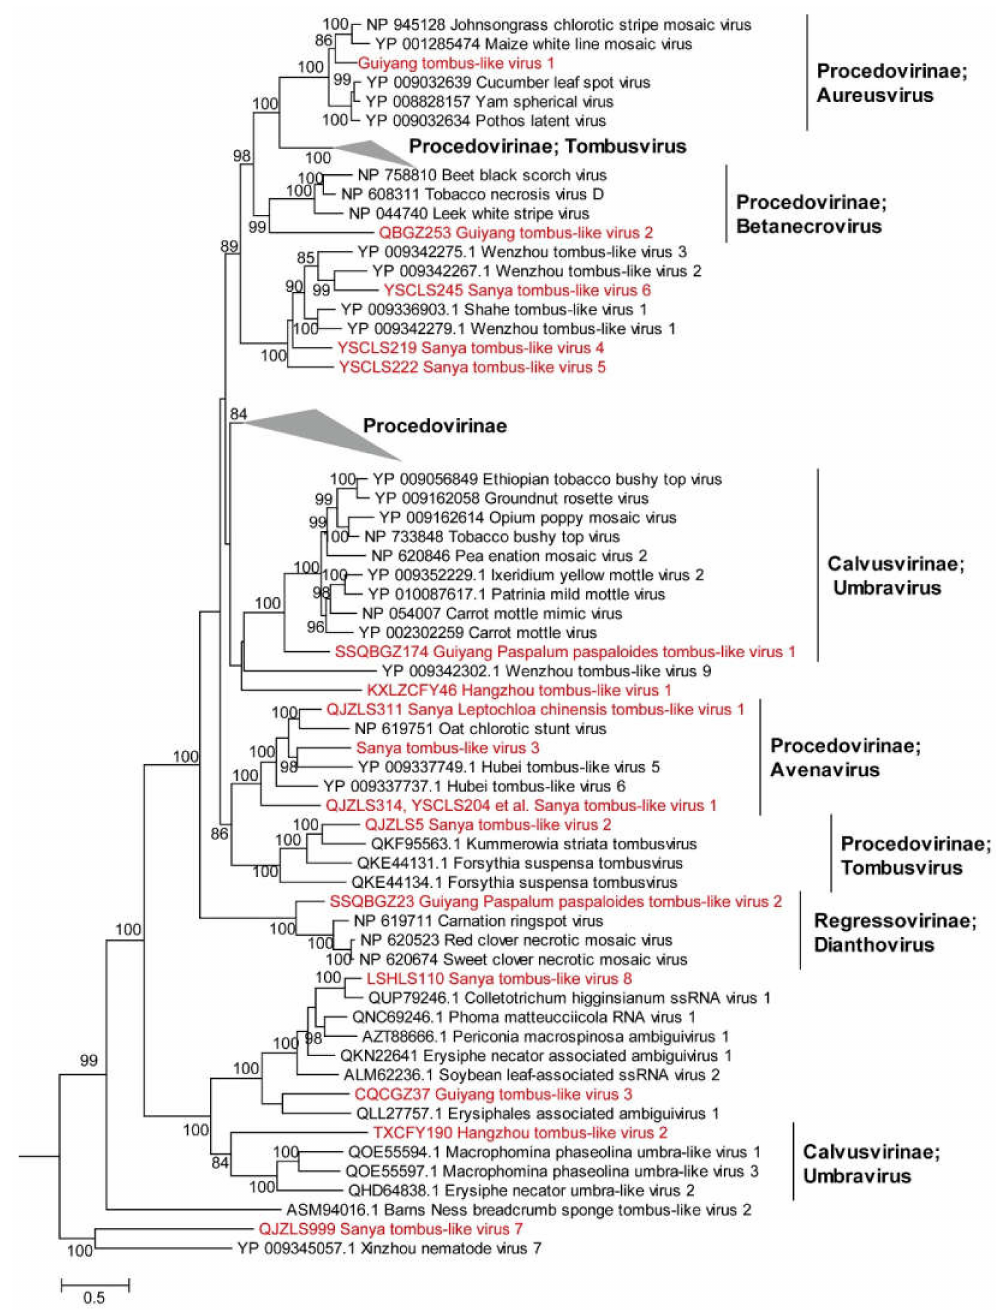
Figure 4. ML phylogenetic analysis of the family Tombusviridae. Phylogenetic trees were constructed using the aligned sequences of RdRp. The names of new viruses discovered in this study are marked in red, the reference virus serial numbers and names are marked in black and the families and genera of viruses (and branches in minimized trees) obtained in this study are marked in bold. The grey triangle means that the clade is all known viruses. The viruses were found in this study are not included in this clade. This clade is large, so it’s